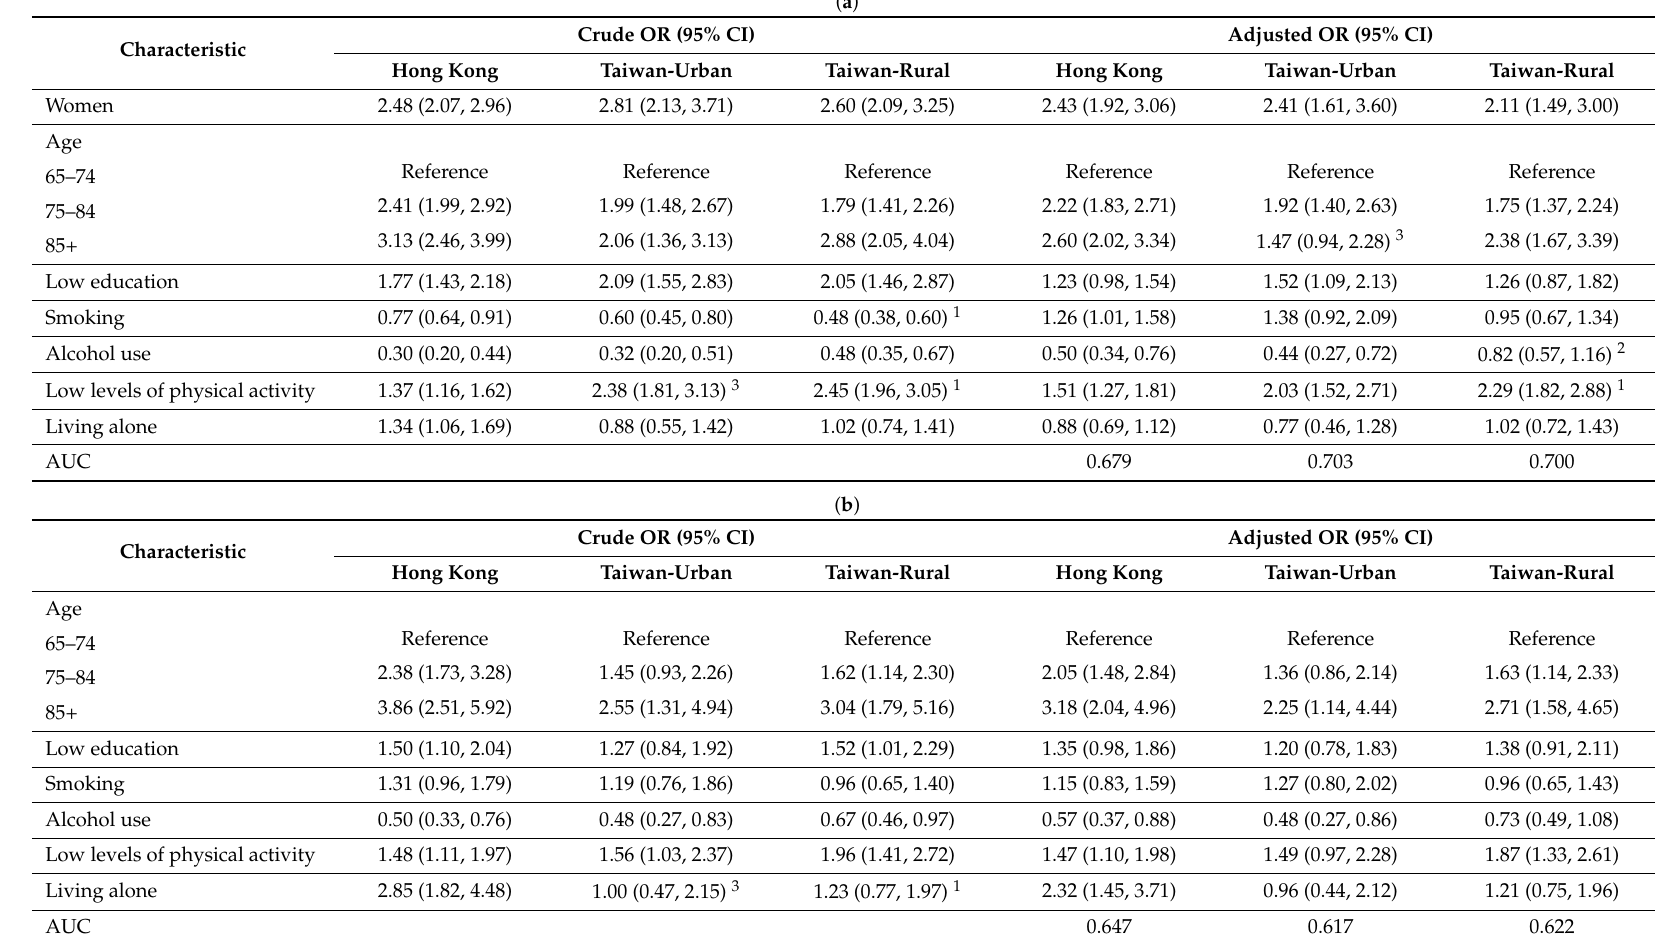
Table 4. ( a ) Multiple logistic regression of frailty in Hong Kong, Taiwan-urban and Taiwan-rural (both sexes); ( b ) Multiple logistic regression of frailty in Hong Kong, Taiwan-urban and Taiwan-rural (men); ( c ) Multiple logistic regression of frailty in Hong Kong, Taiwan-urban and Taiwan-rural